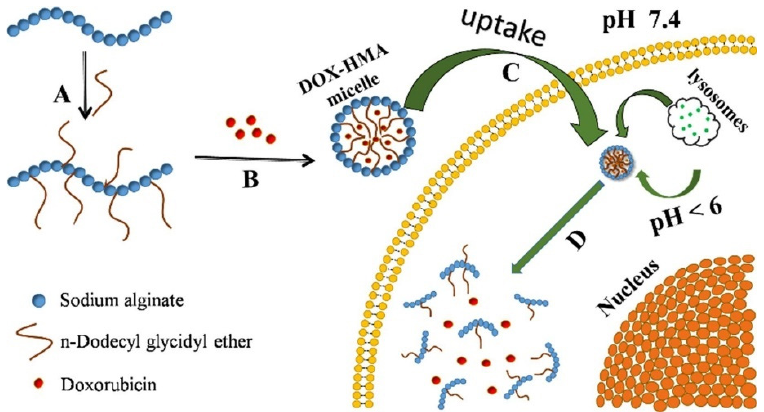
Figure 10. Schematic of synthesis and stimuli‑responsive release of DOX‑HMA micelles: ( A ) dodecyl glycidyl ether‑modified alginate; ( B ) DOX encapsulated into HMA micelles; ( C ) DOX‑loaded HMA micelles accumulated into tumor cells; ( D ) intracellular stimuli‑responsive degradation and drug release. (Reprinted with permission from Ref. [152]. 2020, Xue